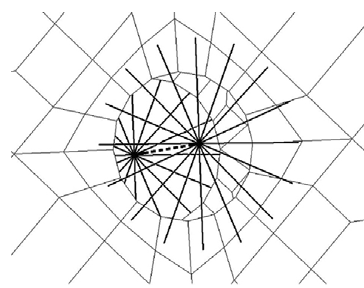
Fig. 21. Bolt model detail in shell-element model